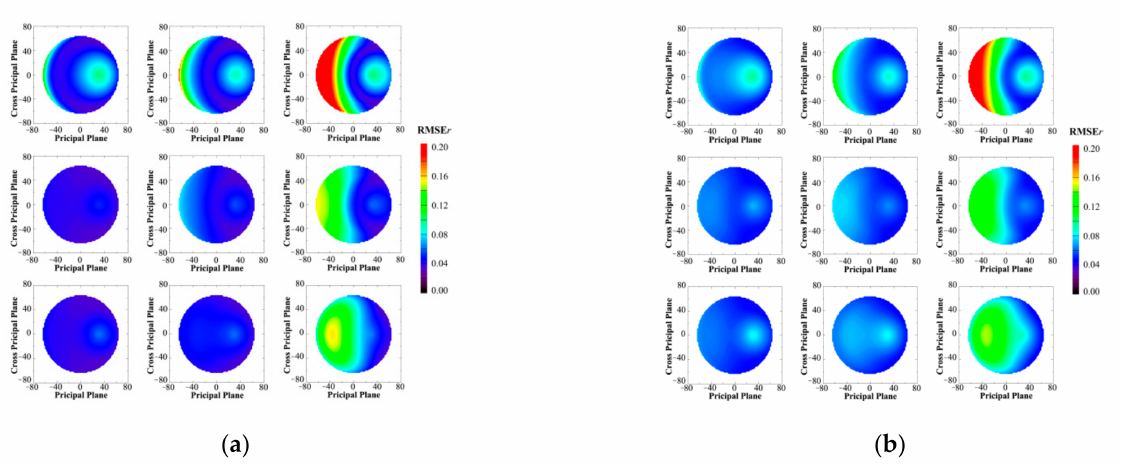
Figure 11. Same as Figure 9, but for the albedo retrieval from directional reflectance with a random noise range from − 20% to 20% in the red ( a ) and NIR ( b ) bands.